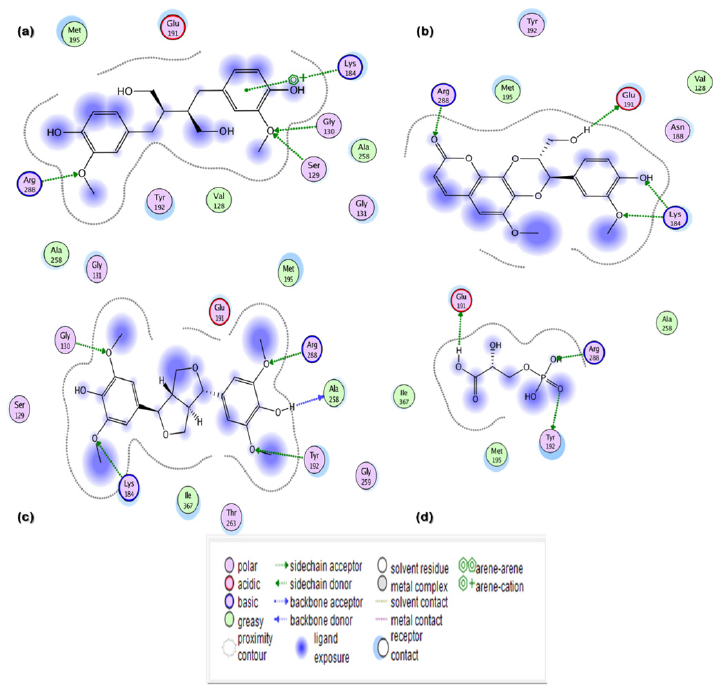
Figure 2. Two-dimensional (2D) interaction maps of hits with potential active site amino acid residues: ( a ) secoisolariciresinol; ( b ) syringaresinol; ( c ) cleomiscosin A; ( d ) 3-PG.